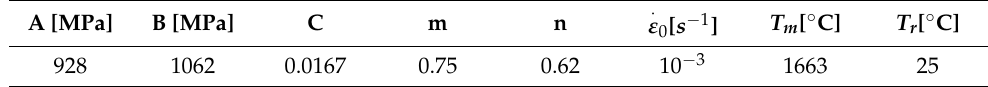
Table 4. Jonson–Cook’s parameters for the titanium alloys Ti-6Al-4V